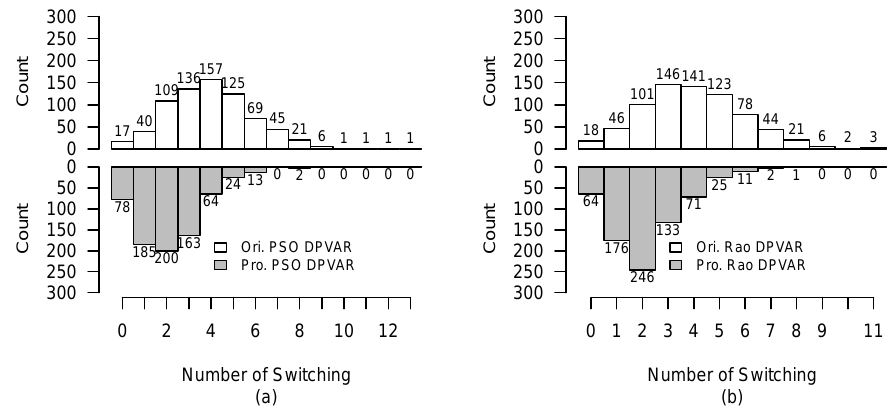
Figure 29. Comparison of switching operation of original-reconfigured and proposed-reconfigured PV arrays under Case 3 with lagged time. ( a ) PSO-reconfigured PV array. ( b ) Rao-reconfigured PV